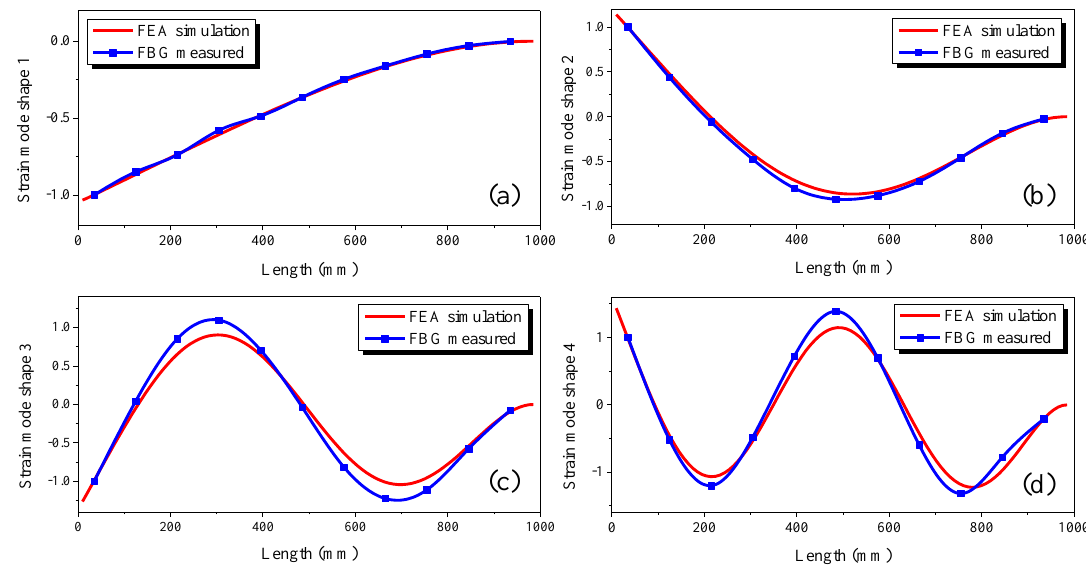
Figure 7. Comparison of normalised strain mode shapes between the results of FEA simulation and experiment, the strain mode shapes along the Z direction of the pipe: ( a ) mode 1; ( b ) mode 2; ( c ) mode 3; ( d ) mode 4.